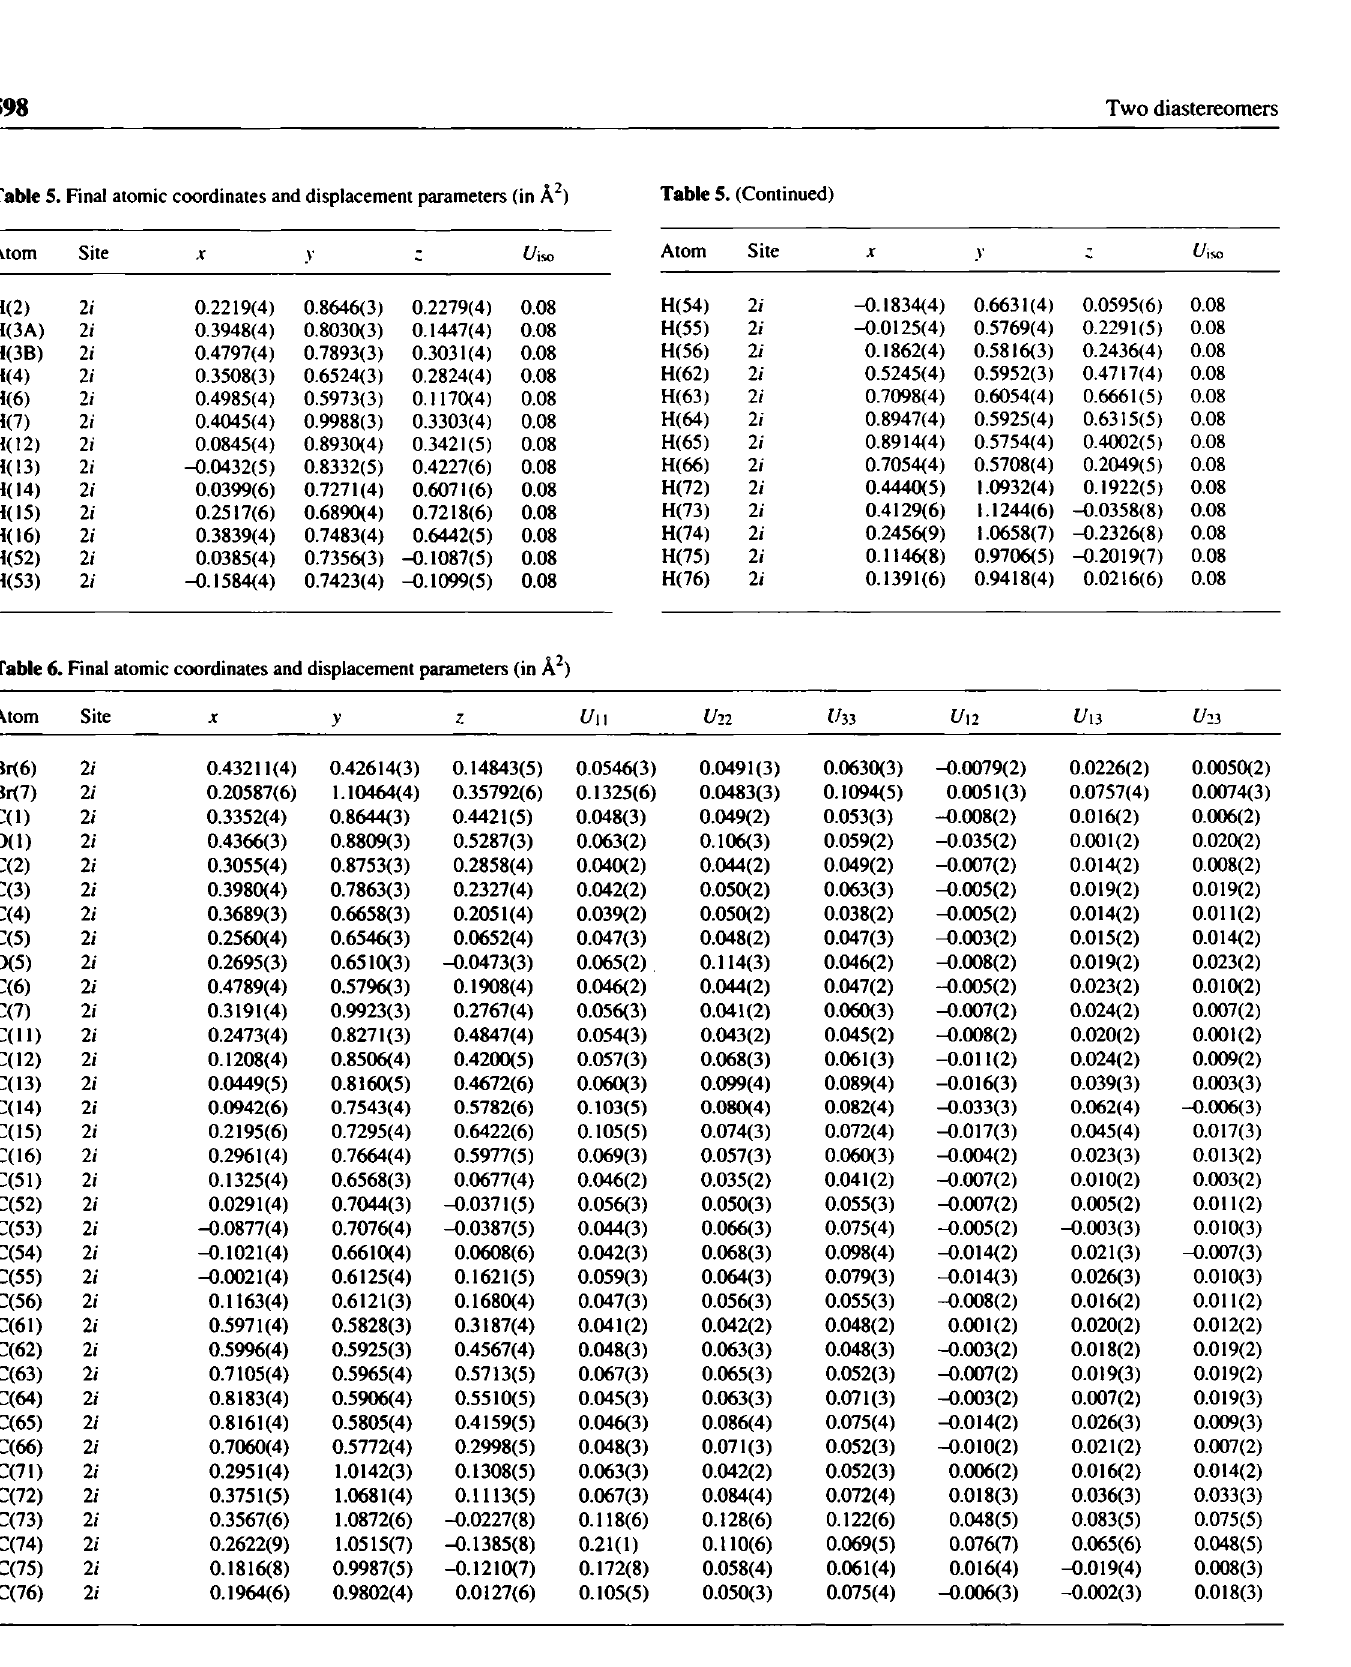
Table 6. Fmal atomic coordinates and displacement parameters (in